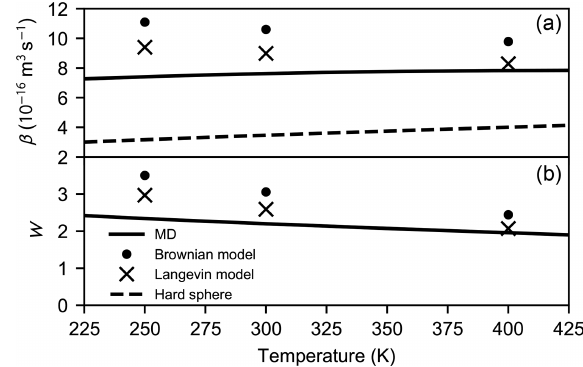
Figure 6. Ratio between the collision cross section σ and a refer- ence value σ 0 as a function of relative velocity. Here the reference value σ 0 is the cross section corresponding to a relative velocity v 0 = 350ms − 1 . The red crosses show the ratio of dynamical cross sections obtained from MD simulations, and the solid black line shows the relation predicted by the Langevin model in Eq. (12).